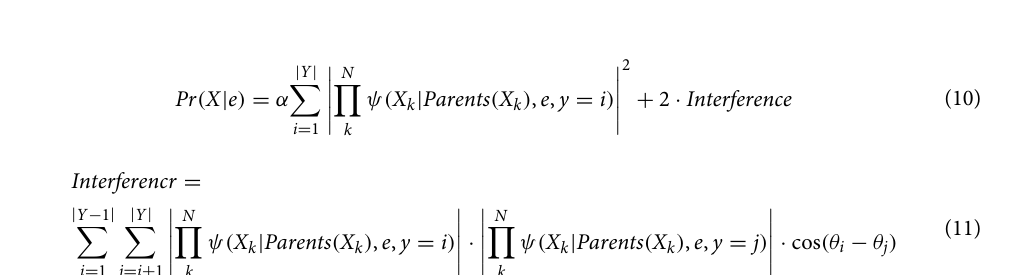
Table 1. The payoff matrix of both sides in the